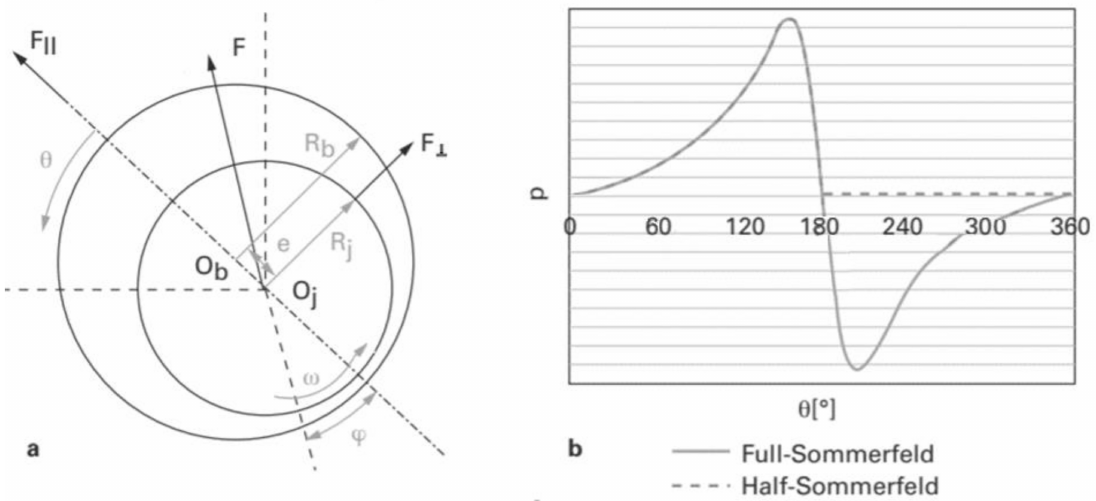
Figure 1. ( a ) Schematic layout of a journal bearing under load (R b bearing radius, R j journal radius, ϕ attitude angle, e eccentricity and ω rotational speed, F resultant force, F || lift force, and F ⊥ drag force); ( b ) Full-Sommerfeld and half-Sommerfeld pressure distribution (Reproduce from [10] with permission from